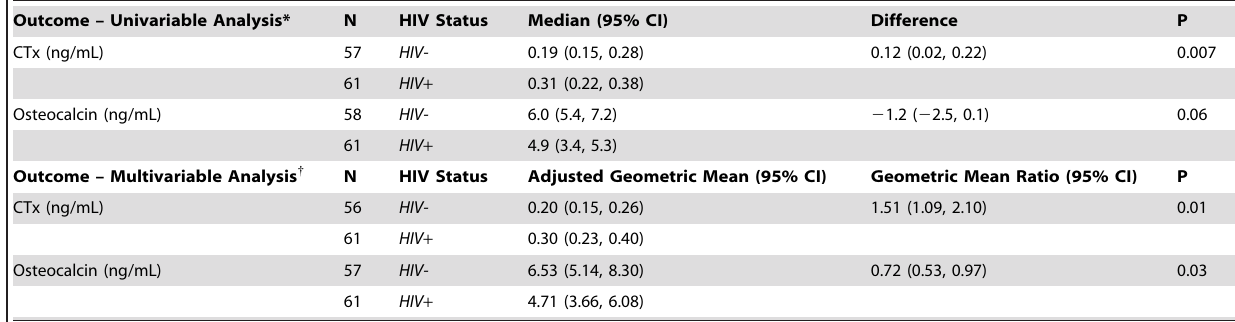
Table 3. Bone turnover outcomes.